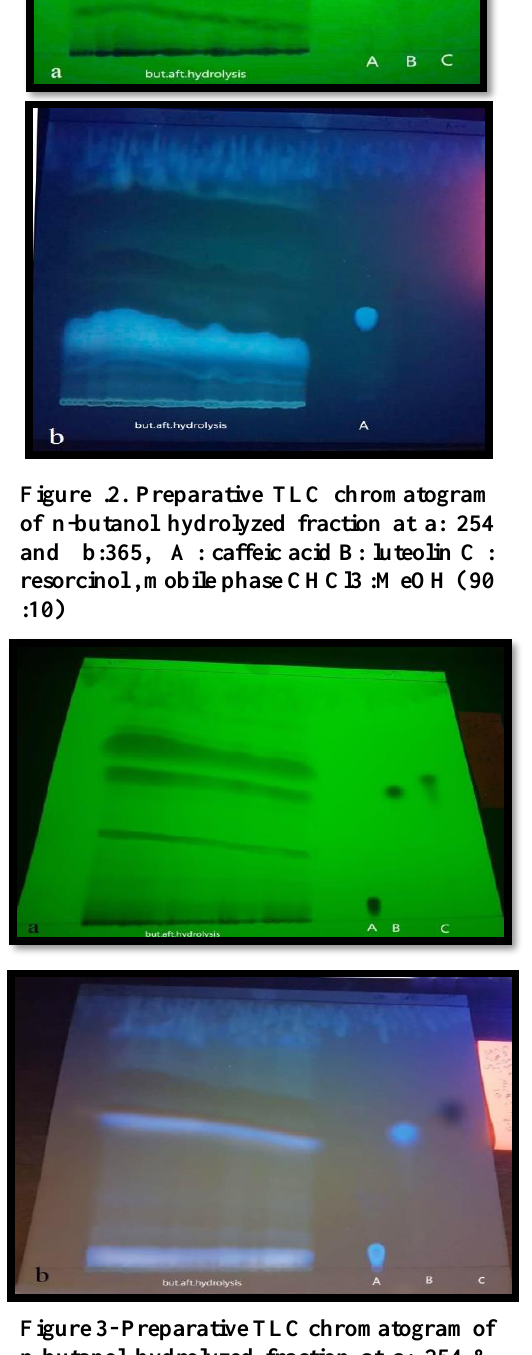
Figure 3- Preparative TLC chromatogram of n-butanol hydrolyzed fraction at a: 254 & b:365, A :Chlorogenic acid B:caffeic acid. C :luteolin, mobile phase CHCl3 :MeOH: formic acid ( 87.5 :10